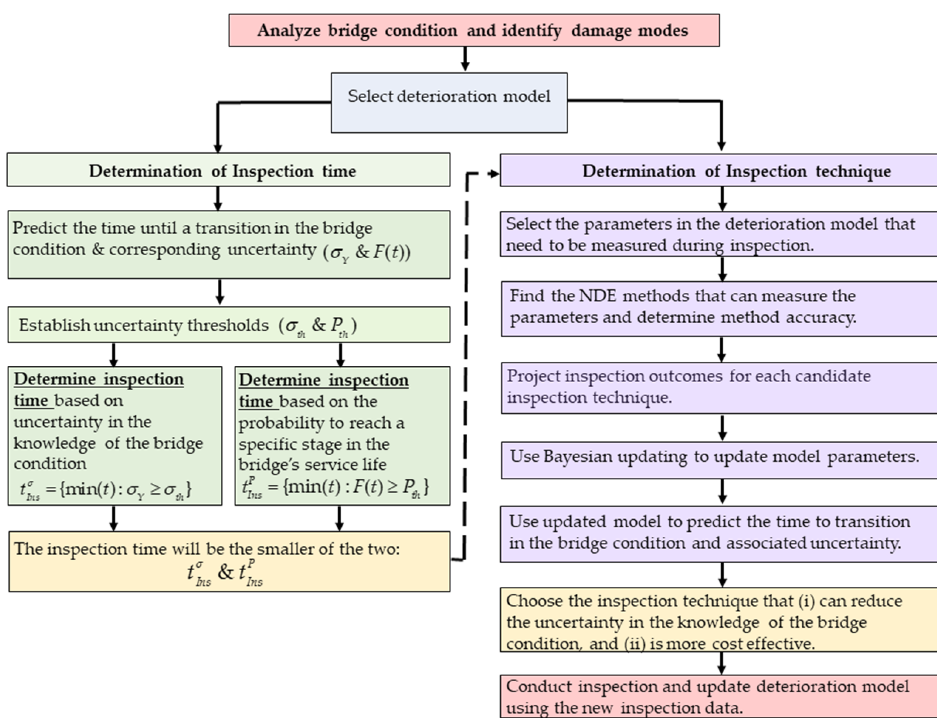
Figure 1. Uncertainty-based inspection framework.